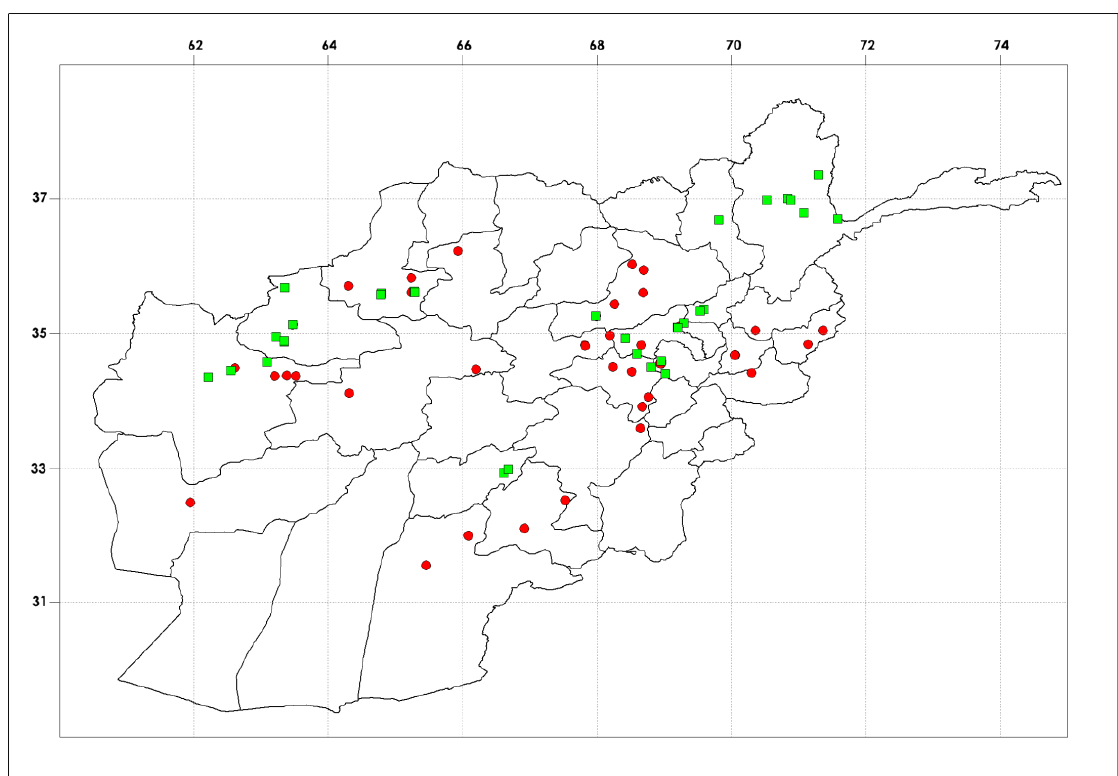
F IGURE 2. Sampling locations of earthworms in Afghanistan. Red Circles. First collection (Omodeo, 1959). Green Squares. Second collection (Omodeo,